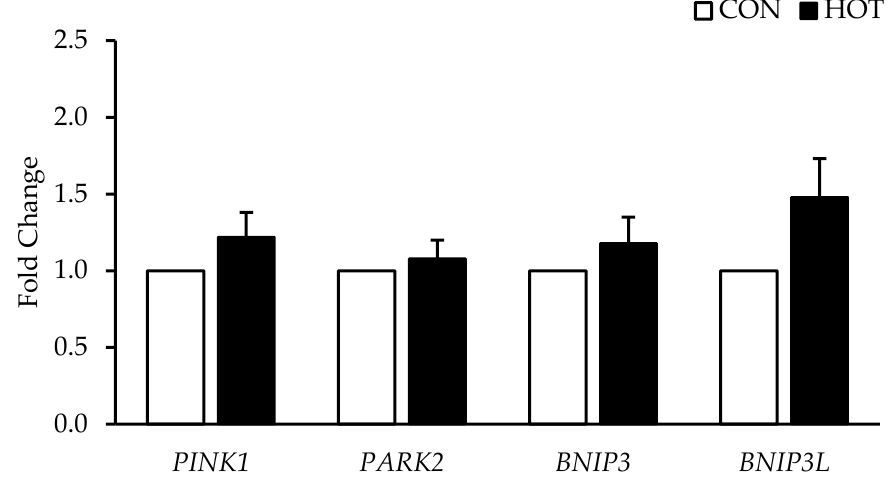
(CON) and heated (HOT) limbs. Data are mean ± SE. HOT is expressed relative to CON (fold change